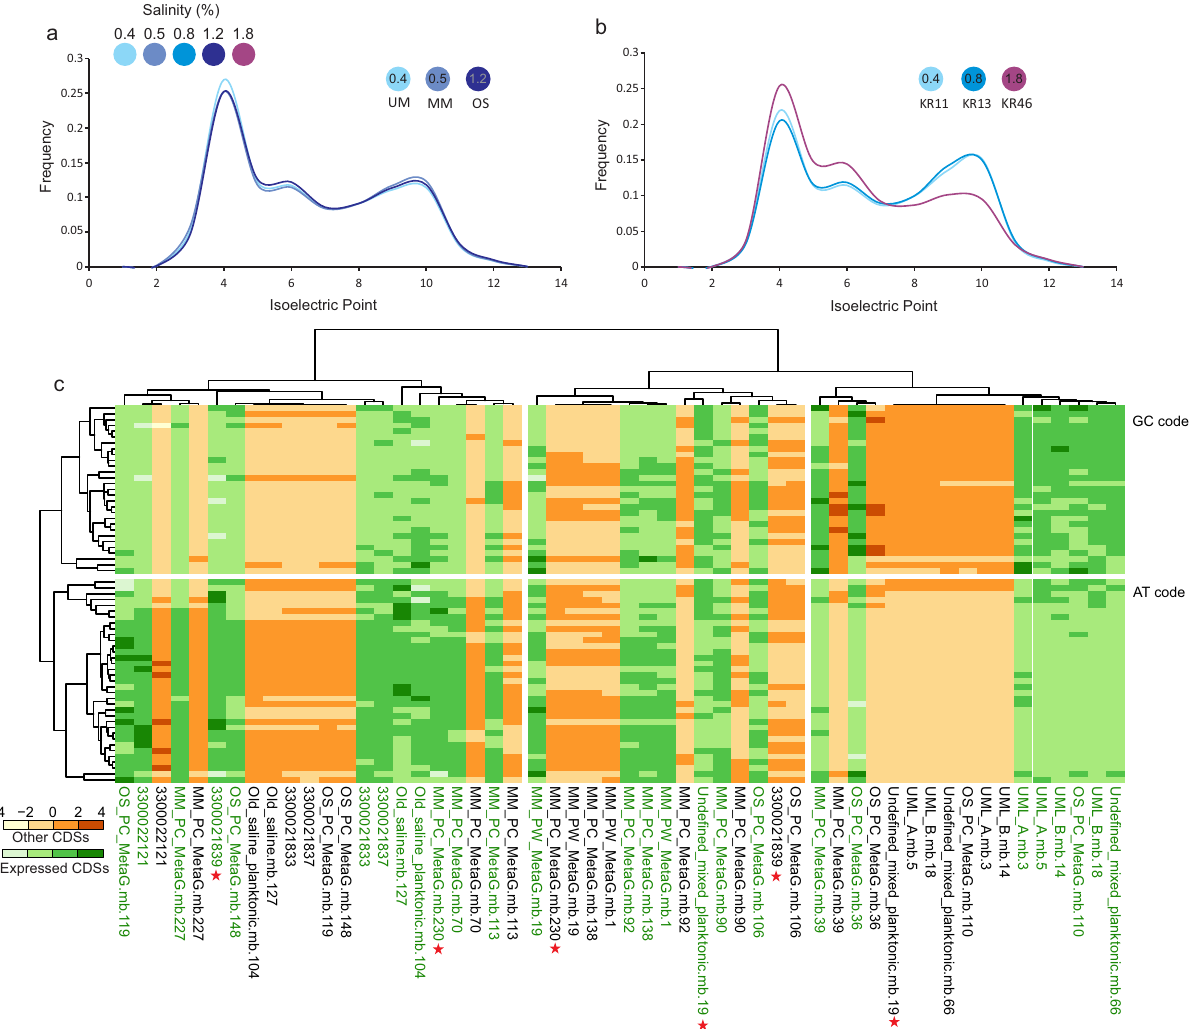
Fig. 4 Adaptations of the coding sequences of the deep groundwater microbiome. Relative frequency of isoelectric points in the predicted proteins of assembled metagenomes from Äspö HRL boreholes ( a ) and Olkiluoto ( b ). Data used to generate these plots are available in the Source Data. The salinity of the water fl owing in each borehole is shown on the top left legend. Representation of frequency (the expected number of codons, given the input sequences, per 1000 bases) of the utilization of synonymous codons across MAGs and SAGs of different genomes clusters of highly expressing Desulfobacterota. Codon usage frequencies are calculated separately for the CDSs for which RNA transcripts are detected (green) and the rest of CDSs not actively being transcribed in the sequenced metatranscriptomes (orange) ( c ). Stars showcase potential transcription ef fi ciency control via codon usage